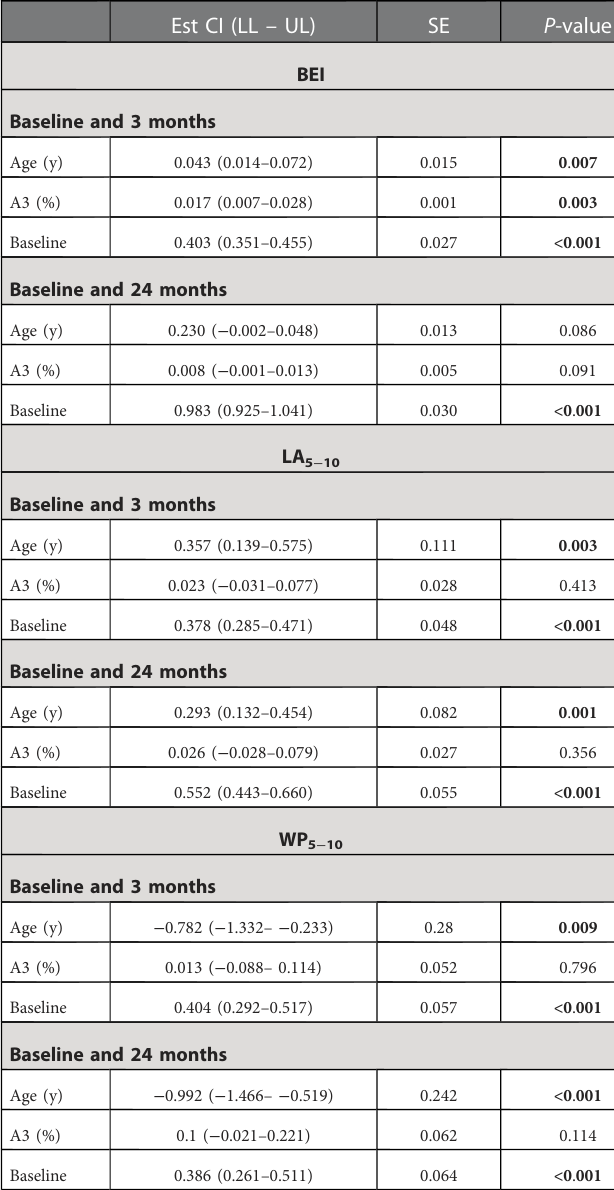
TABLE 3 Linear model to predict changes in airway parameters associated with air trapping. Patient and lung regions are random effects. The fi xed effects were age, A3, and the examination time point (3 months, 12 months, and 24 months), and the endpoints were the airways parameters BEI, LA 5 − 10 , and WP 5 − 10 . The regression coef fi cient (EstE) describes the in fl uence of a fi xed effect on the endpoints if it is increased by one unit. The con fi dence interval (Cl) with its lower and upper limits (LL – UL) and the standard error (SE) is also given.